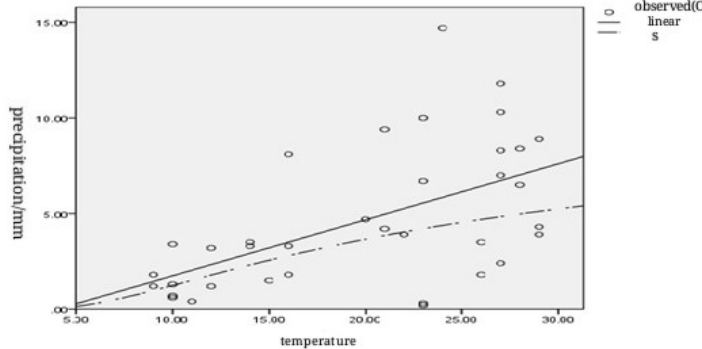
Figure 4. Figure monthly average precipitation and temperature relationship from 2014-2016 in